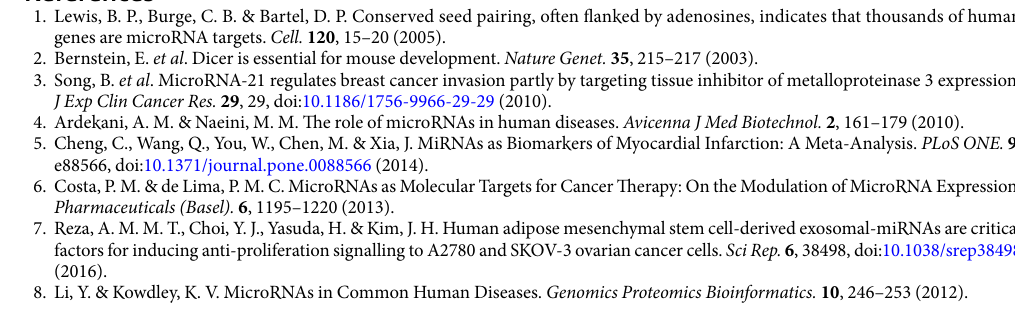
In silico analysis using the TCGA database. The genetic alteration status and consequences of the altera- tion of RPS16 and TNFSF10 , along with their mutually co-expressed genes in breast cancer patients were analyzed using the cBioPortal for Cancer Genomics (http://www.cbioportal.org/index.do) database from TCGA Research